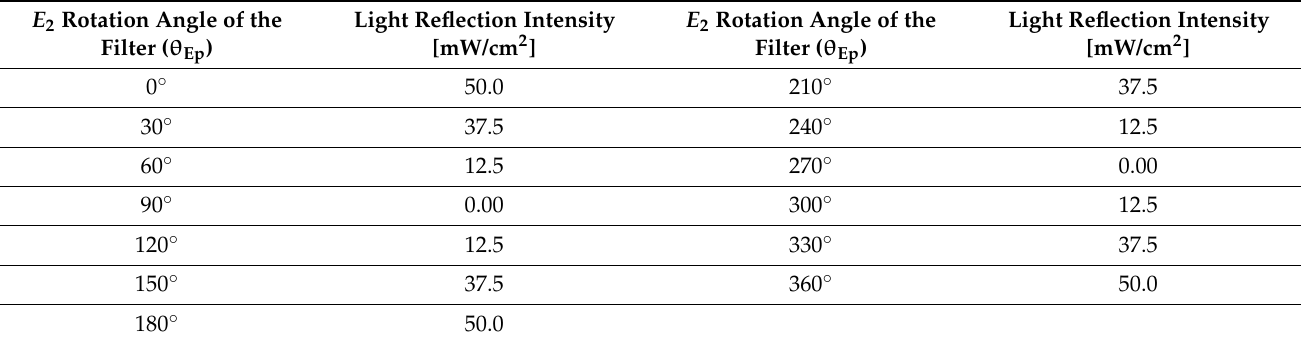
Table 1. Analysis of changes in light reflection intensity according to the rotation angle of the filter ( E 2 @ E 1 = 50 mw/cm 2